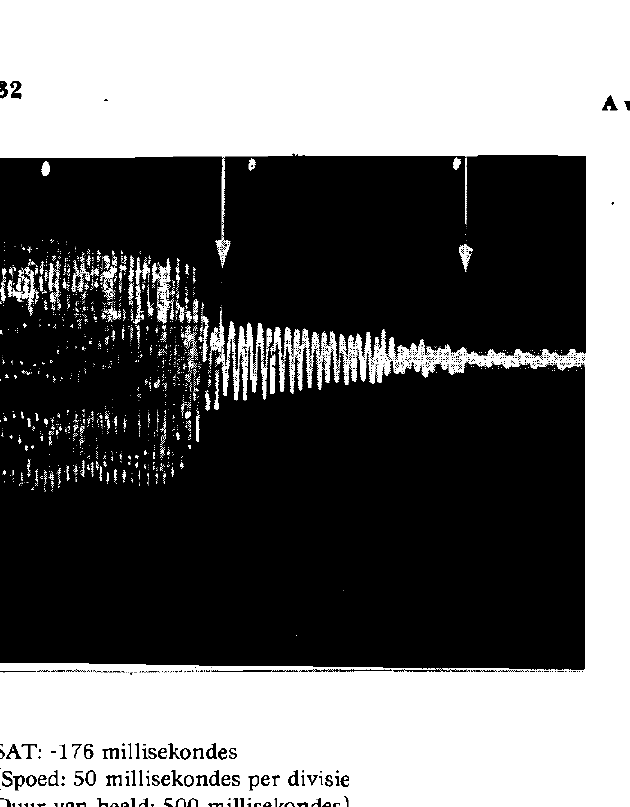
Figuur 6: Voorbeeld van die vokaalduur van 'n normale spreker.